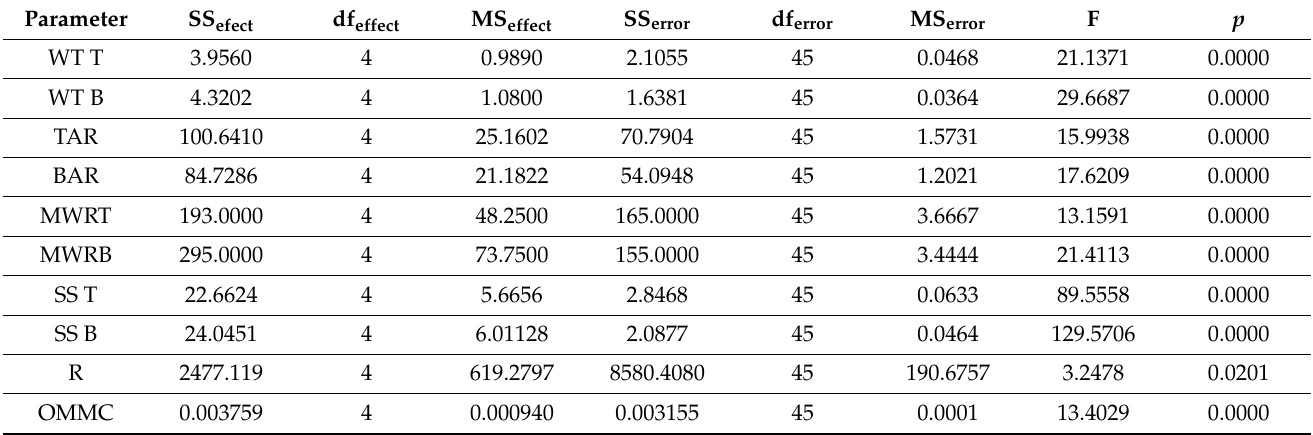
Table 4. The results of the one-way ANOVA.